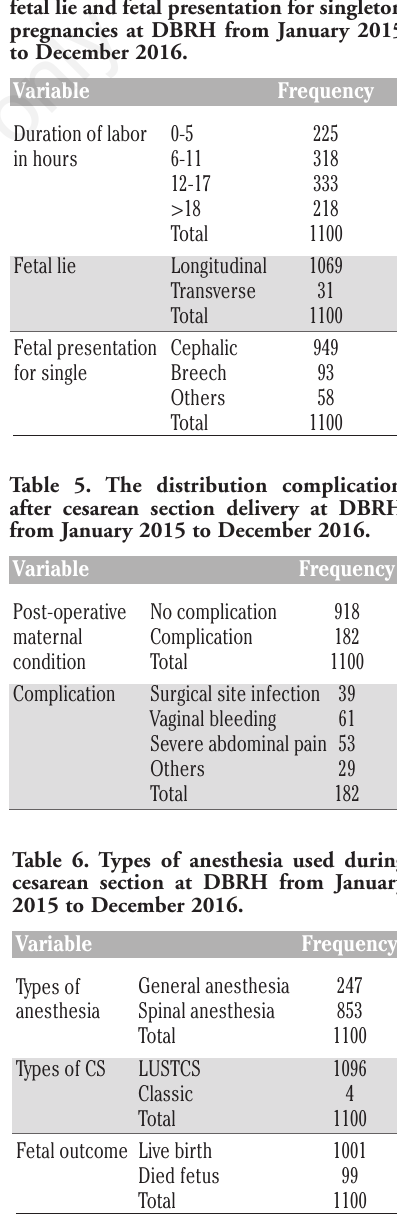
Table 4. Distribution of duration of labor, fetal lie and fetal presentation for singleton